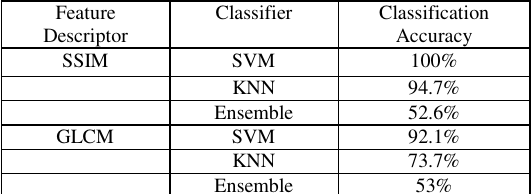
Fig. 8: ROC for Classification using SVM under GLCM Criteria Table 2: Classification accuracy for Malignant And Benign Liver Tumors by applying GLCM and SSIM